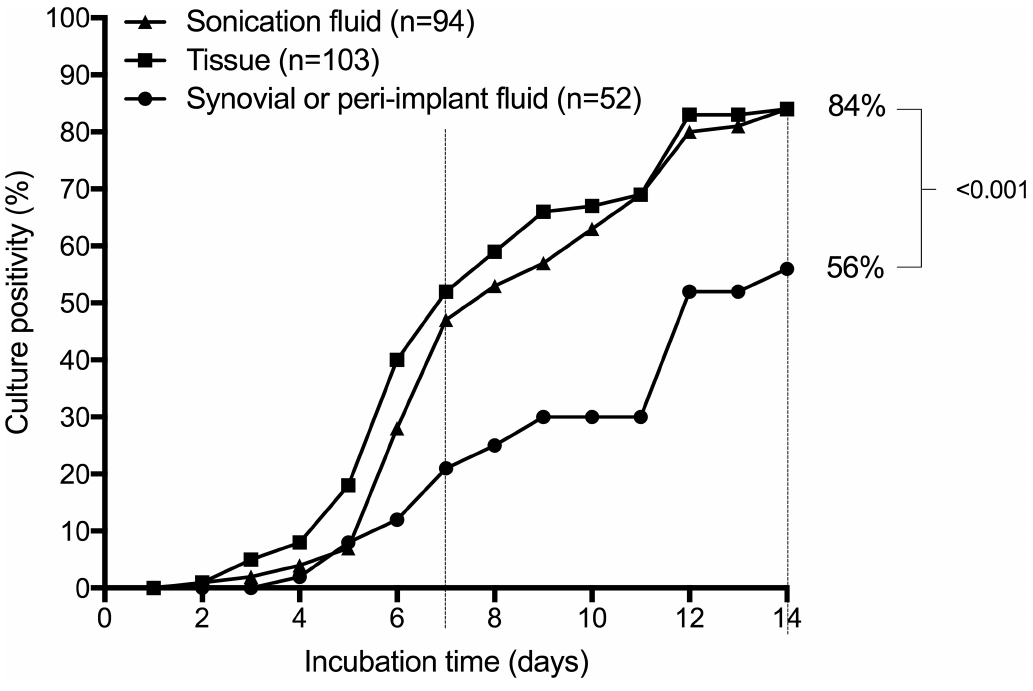
Fig 2. Times to culture positivity of synovial or peri-implant fluid, peri-implant tissue and sonication fluid. The dotted lines indicate the incubation time of 7 and 14 days.